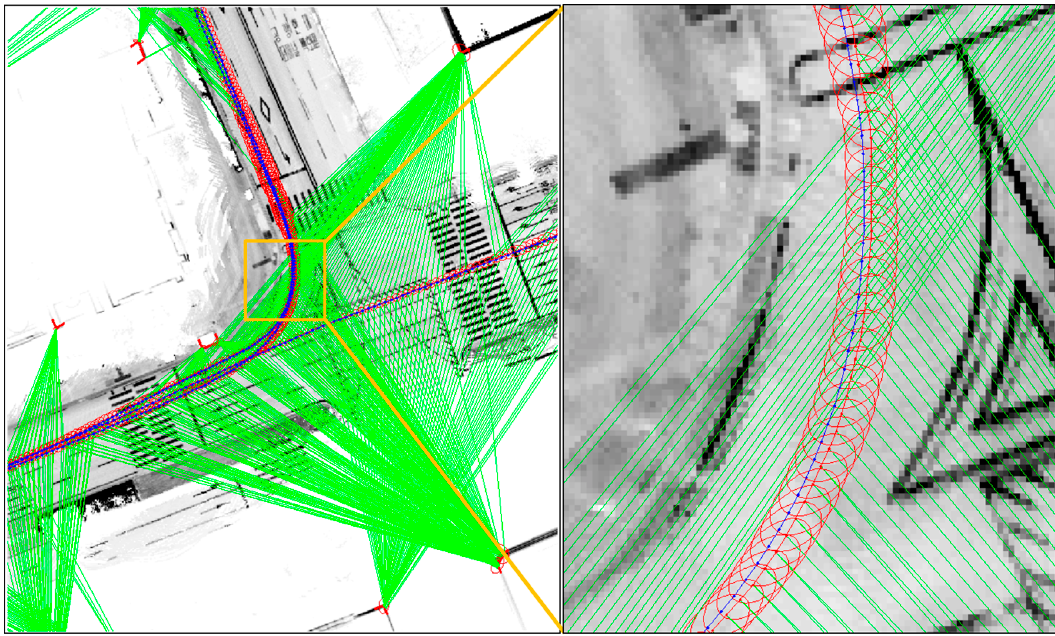
Figure 27. Estimated vehicle trajectory in the situation affected by the poor corner measurement (the blue trajectory is the ground truth).